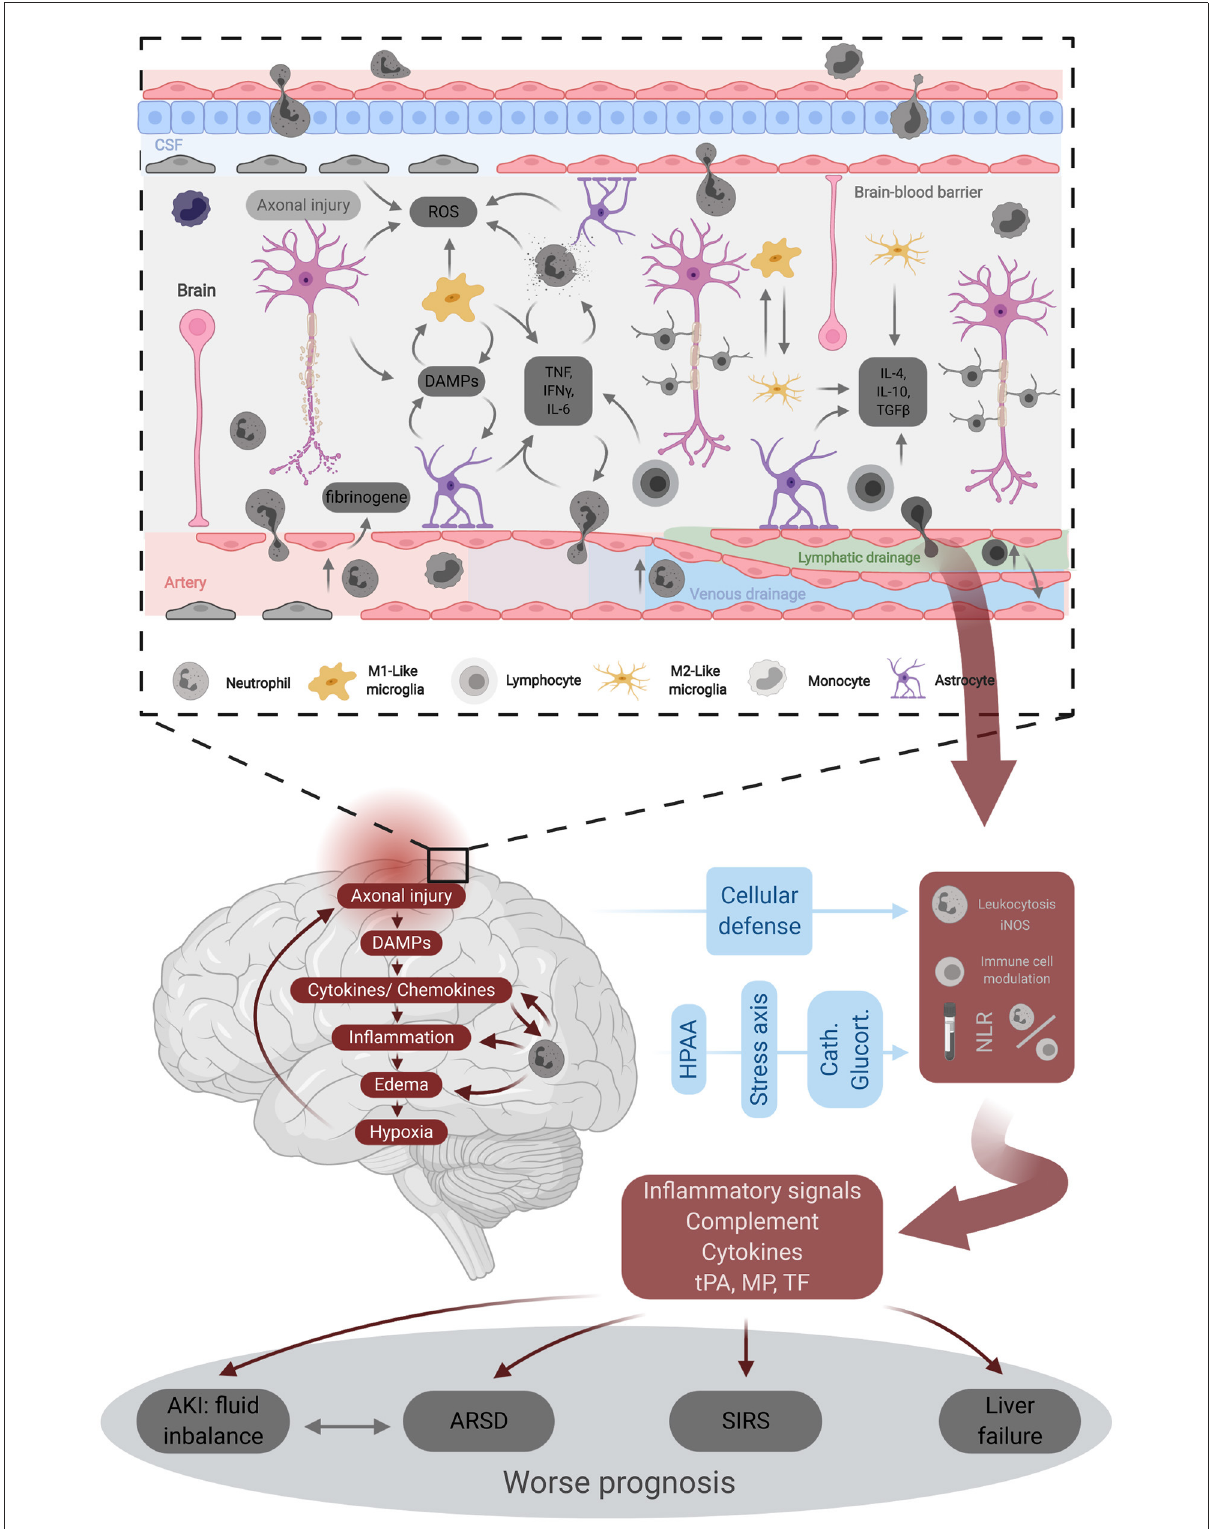
FIGURE3 Underlying pathophysiology of traumatic brain injury. DAMPs, Damage-associated molecular patterns; iNOS, inducible nitric oxyde synthase; MP-TF, micro particles tissue factor; ROS, reactive oxygen species; SIRS, systemic inflammatory response syndrome; tPA, tissue plasminogene